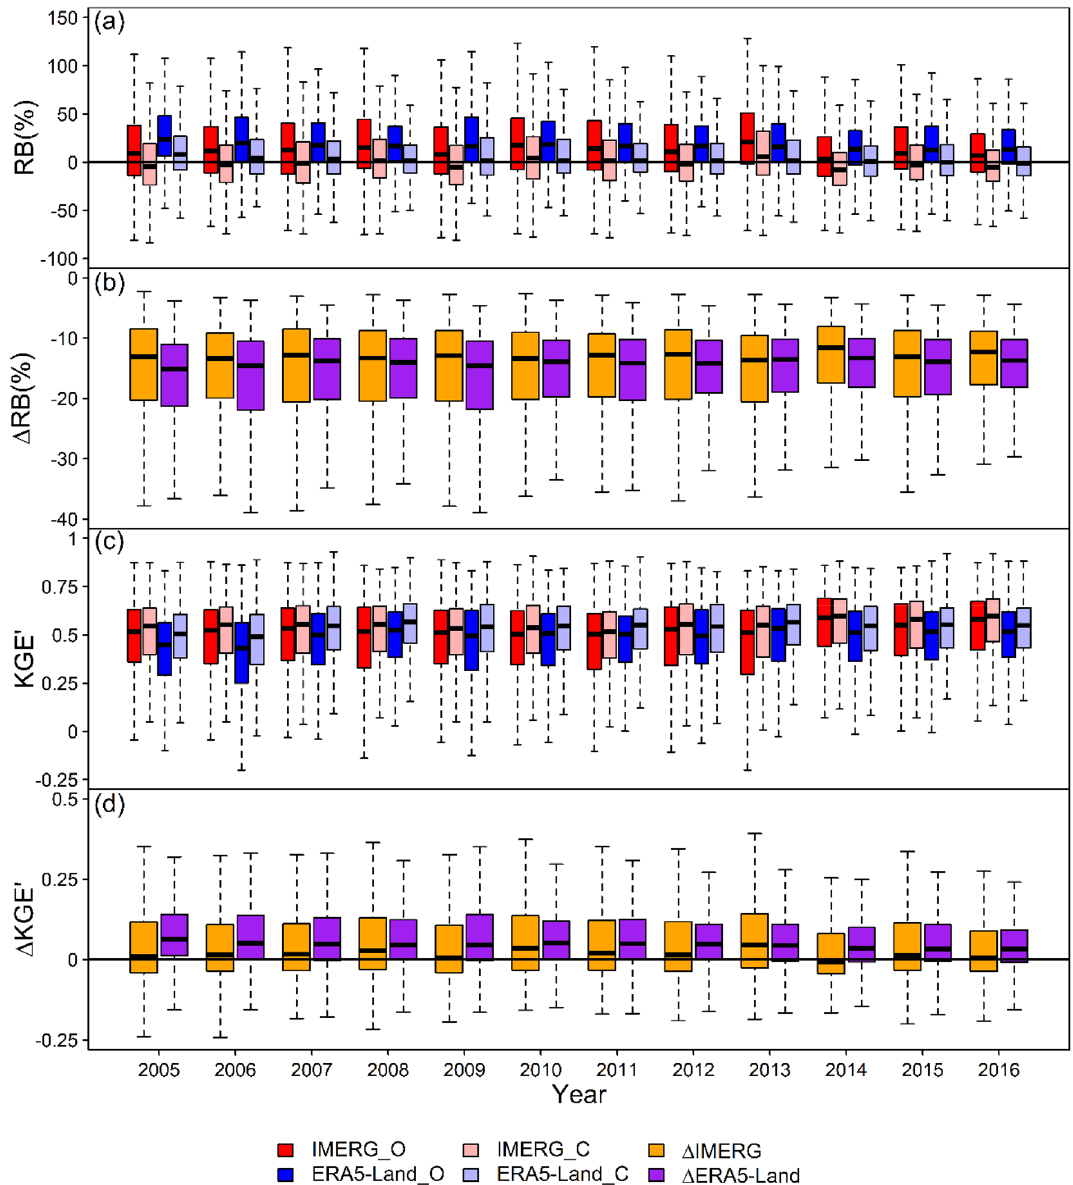
Figure 6. Boxplots of ( a ) RB (RB_O and RB_C), ( b ) ∆RB, ( c ) KGE ʹ (KGE ʹ _O and KGE ʹ _C), and ( d ) ∆KGE ʹ for IMERG and ERA5-Land at inter-annual